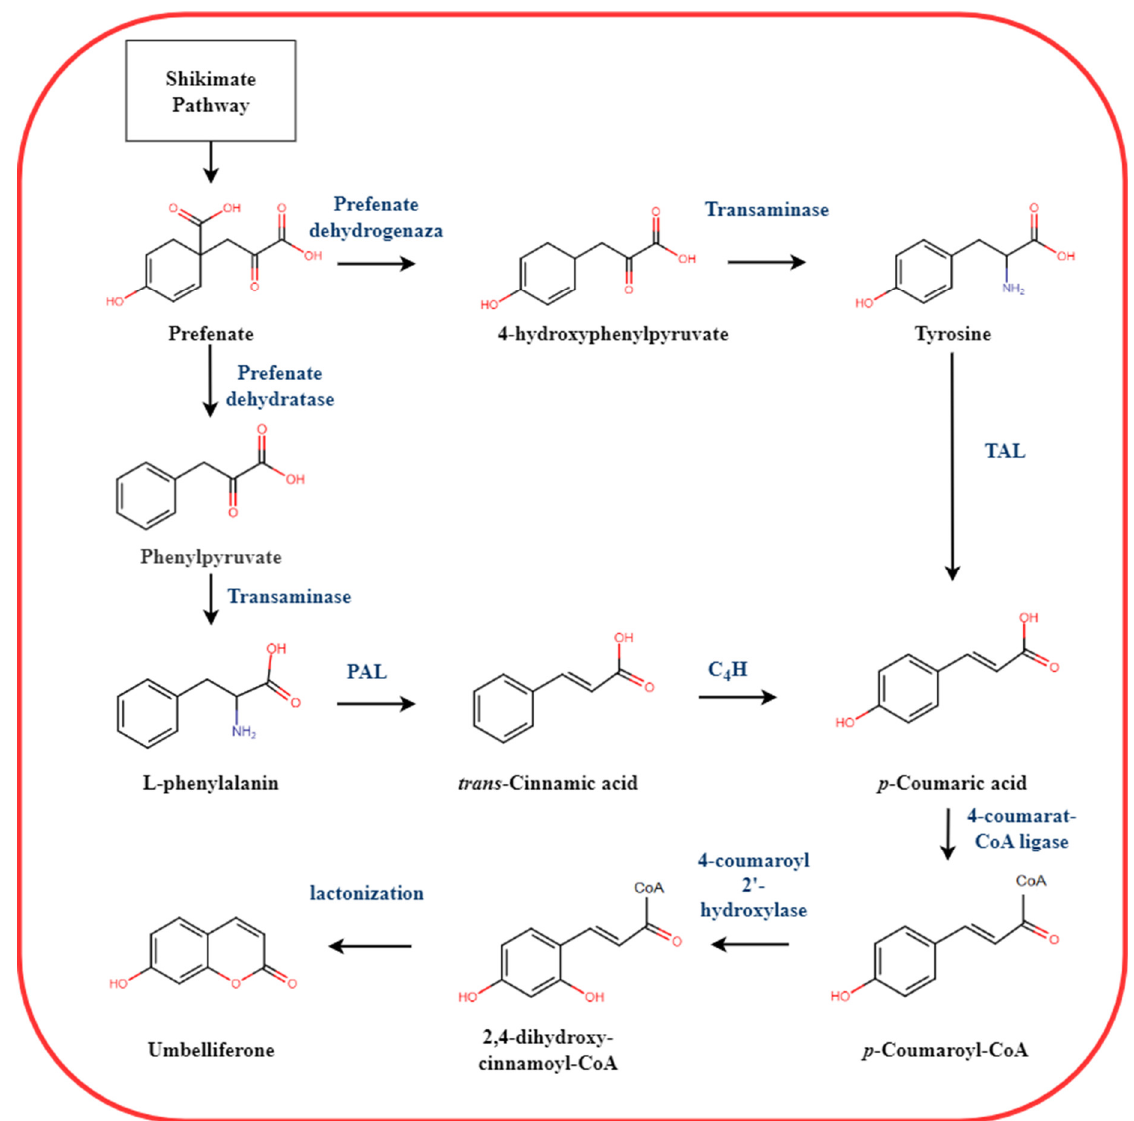
Figure 2. Biosynthesis pathway of umbelliferone, a precursor of pyranocoumarins.